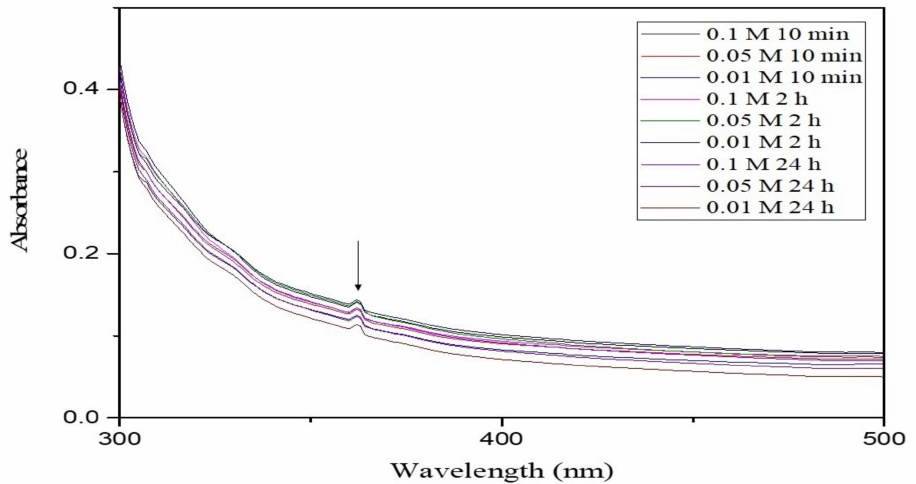
Figure 6. UV–visible spectra of biosynthesized ZnO NPsAL prepared with various concentrations of zinc nitrate at different wavelengths and incubation periods. Adapted from Umar et al. (2019) [19].